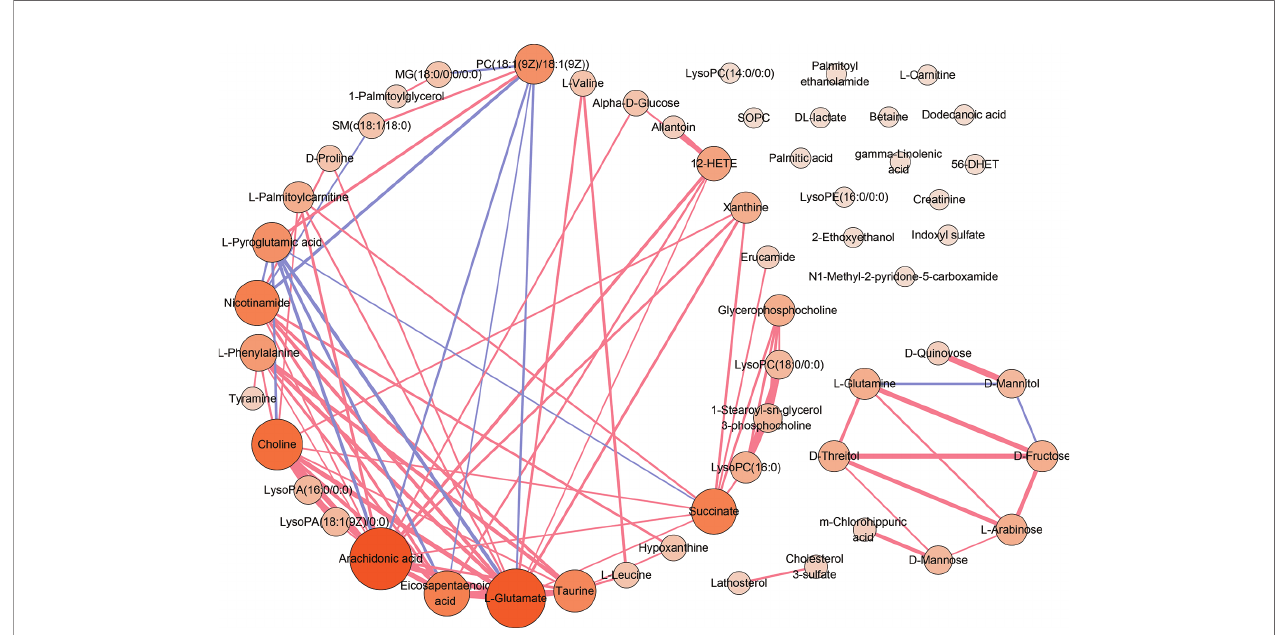
FIGURE 4 | The correlation analysis of 55 serum differential metabolites. The correlation-based network deduced from 55 differential serum metabolites. Only moderate correlation or above (correlation coef fi cient ≥ 0.6 or ≤− 0.6, p <0.05) serum metabolite pairs were included. Red edges denote correlation coef fi cient ≥ 0.6. Purple edges denote correlation coef fi cient ≤− 0.6. The width of edge represents the intensity of correlation. Nodes denotes metabolites. The color depth and the sizes of nodes represent the number of correlated metabolites linked to the certain metabolite